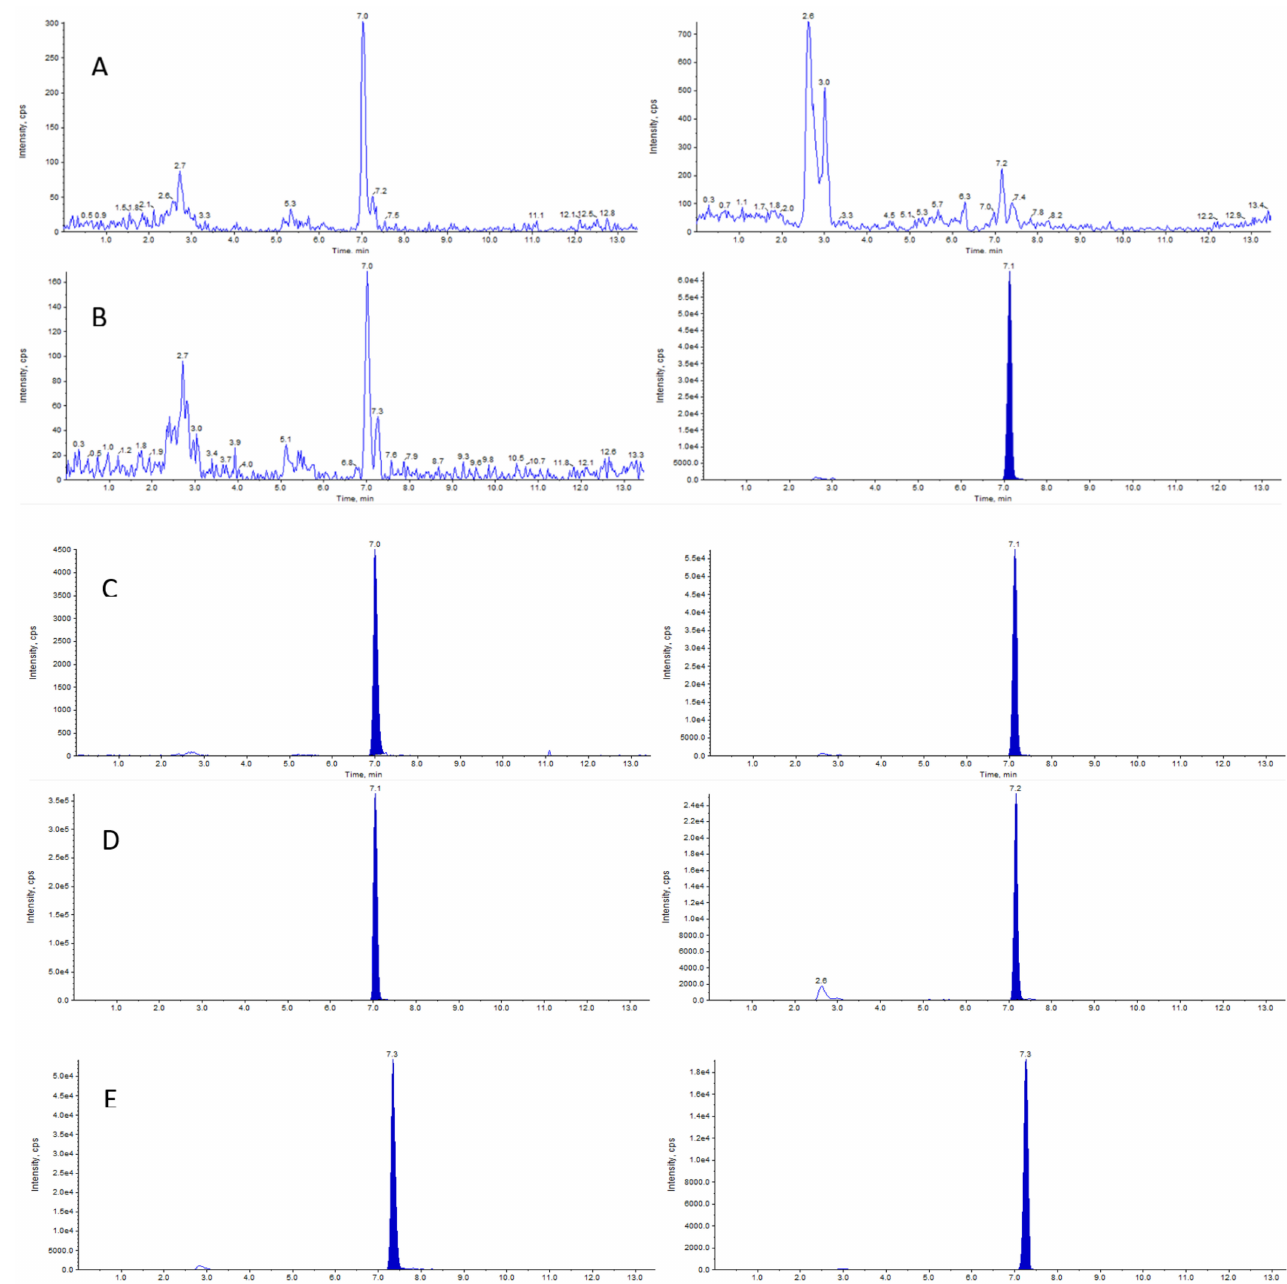
Figure 4. Representative chromatograms of a double blank plasma sample ( panel ( A )), blank with internal standard IS (ZST152, panel ( B )), LLOQ of ZST316 with IS (ZST152, panel ( C )), and of unknown study plasma samples analyzed for ZST316 with IS (ZST152, panel ( D )) and ZST152 with IS (ZST316, panel ( E